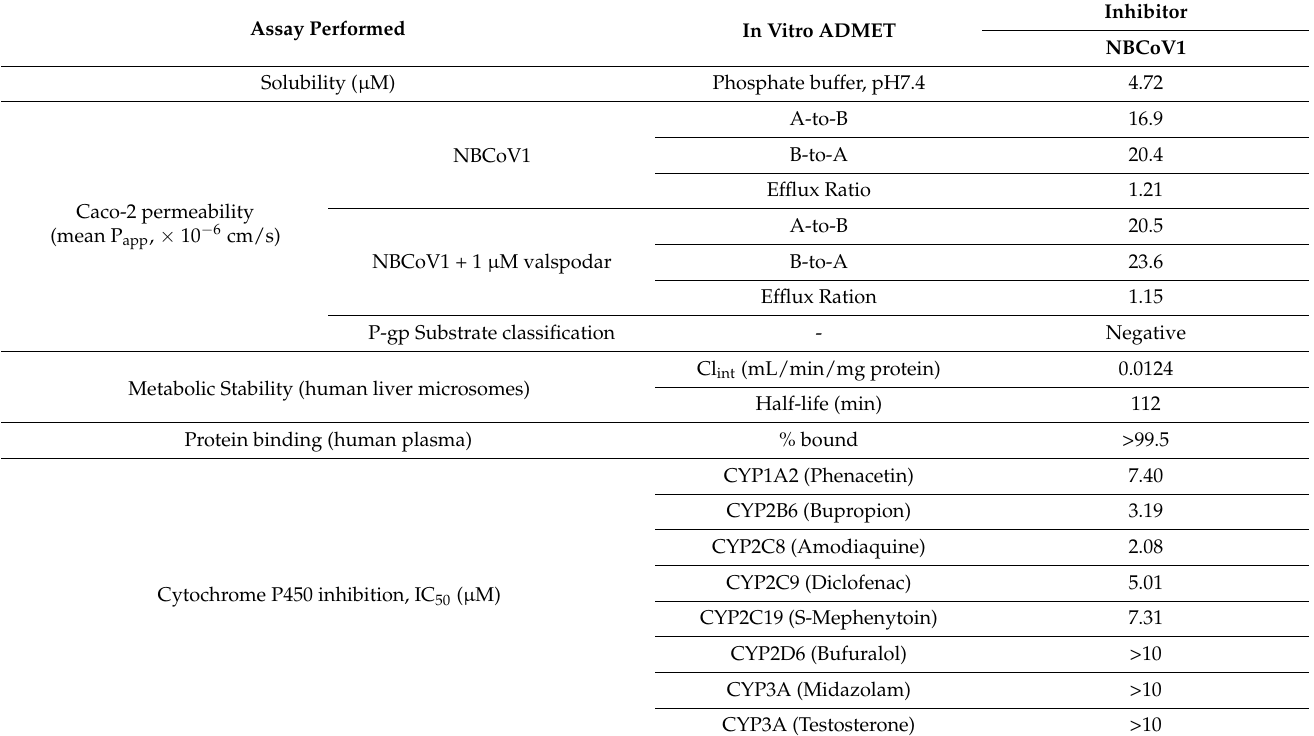
Table 7. In vitro ADME profile of one of the most potent inhibitors NBCoV1. Assay